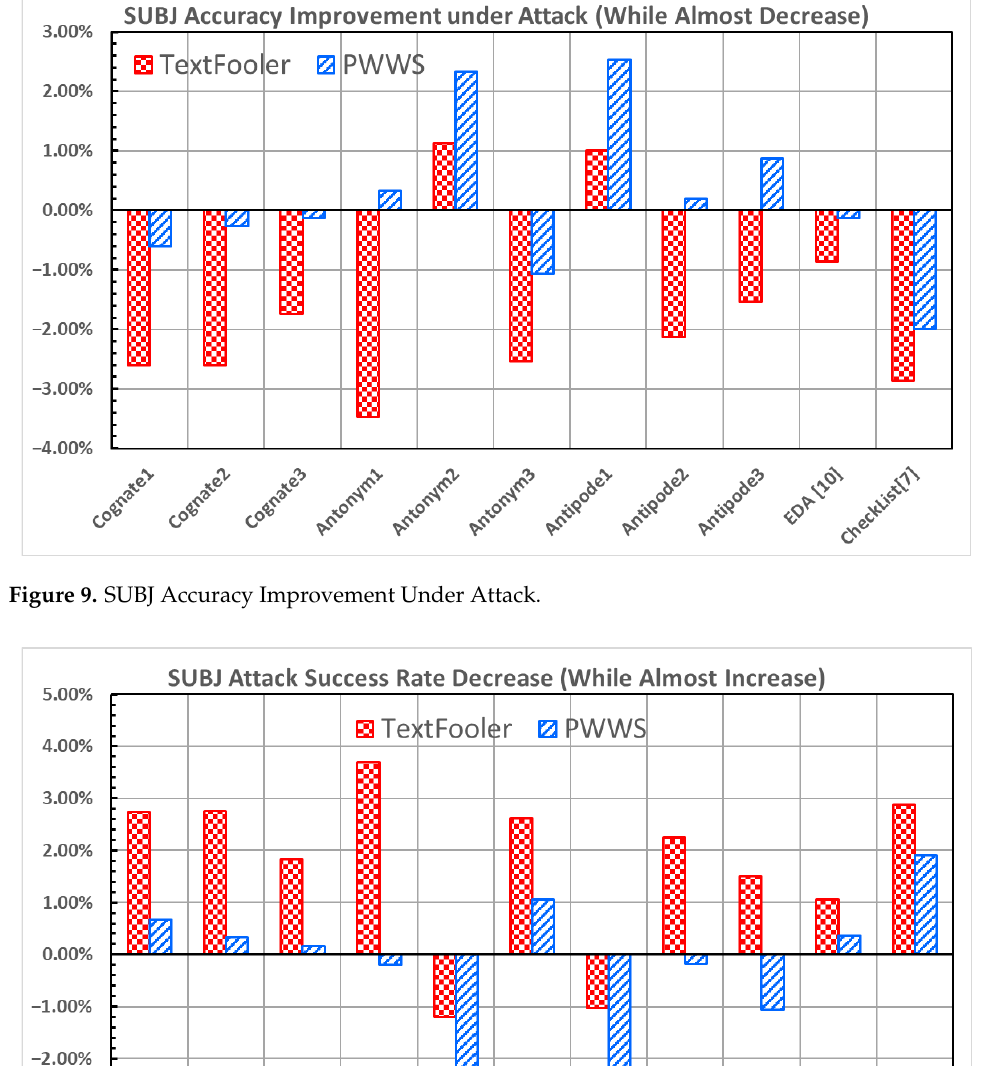
10 of 21 Figure 8. TREC Attack Success Rate Decrease.